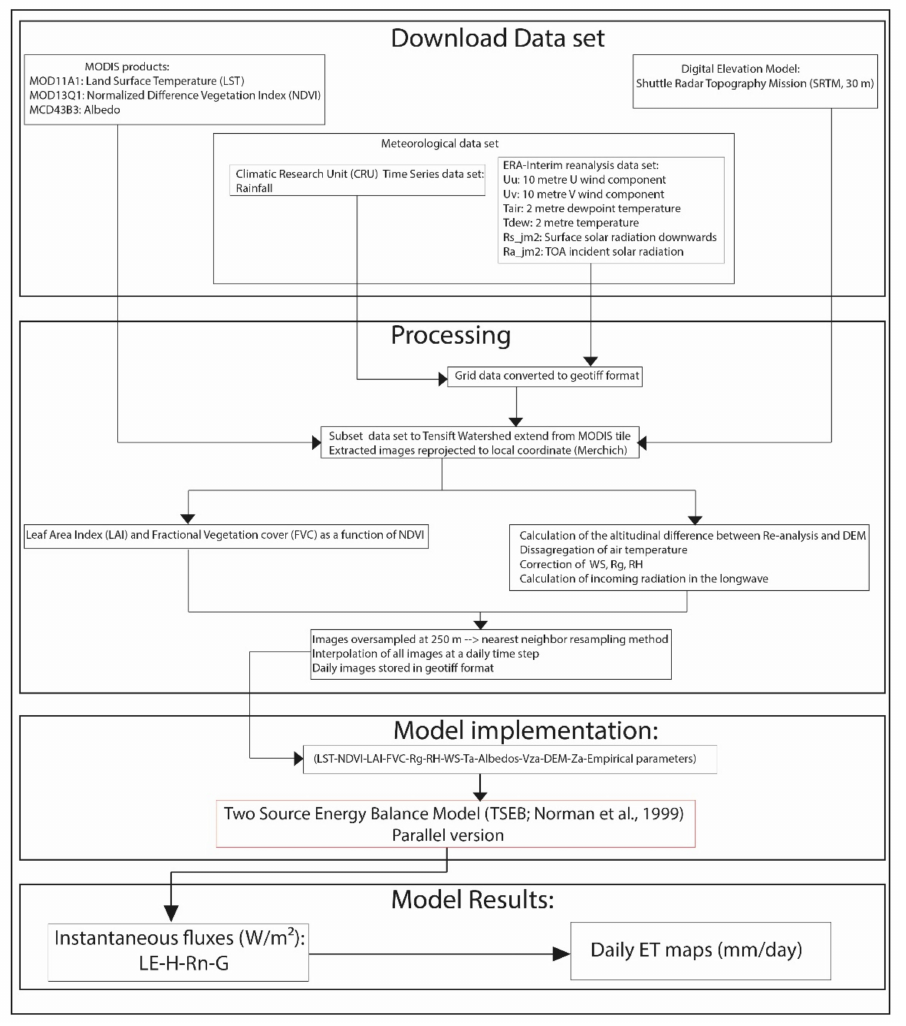
Figure 2. Flowchart of the methodology used in this study. Ts = surface temperature ( ◦ C); Ta = air temperature ( ◦ C); RH = relative humidity (%); Rg = global radiation (W/m 2 ); WS = wind speed (m/s); Rn = net radiation (W/m 2 ); G = soil conduction (W/m 2 ); H = sensible heat flux (W/m 2 ); LE = latent heat flux (W/m 2